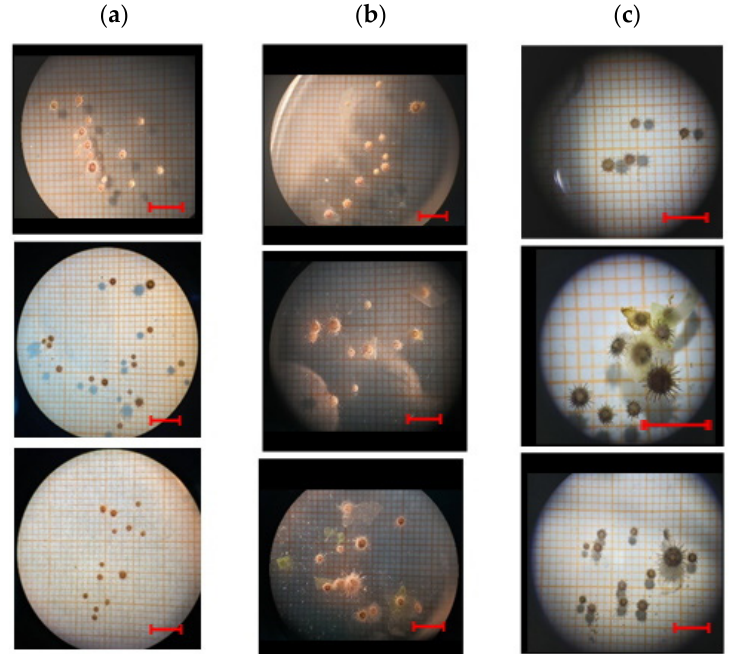
Figure 4. P. lividus post-larvae size captures at t 0 , t f/2 and t f in the replicates of ( a ) control diet, ( b ) diet A and ( c ) diet B. The red scale bar measures 10 mm, according to the magnification under optical microscopy.